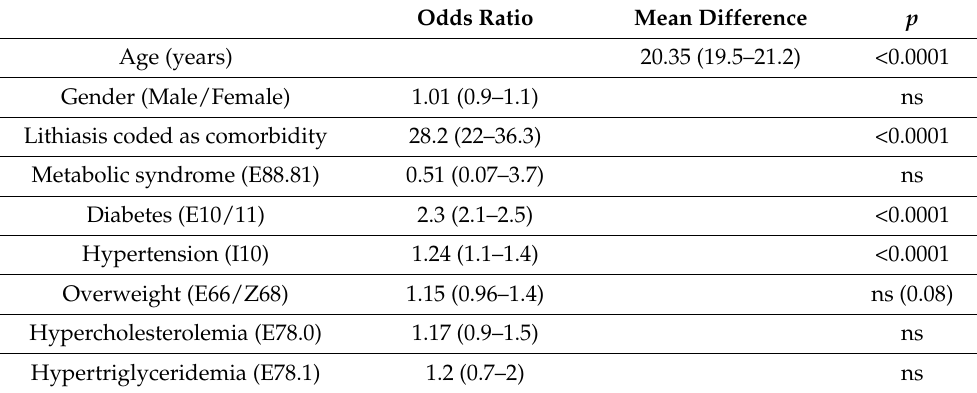
Table 9. Association of demographical and metabolic syndrome traits and risk of mortality in patients with renal lithiasis using a univariate analysis (categorical variables: chi 2 , continuous variables: t test). Results are given with 95% confidence interval in brackets. ns: p >